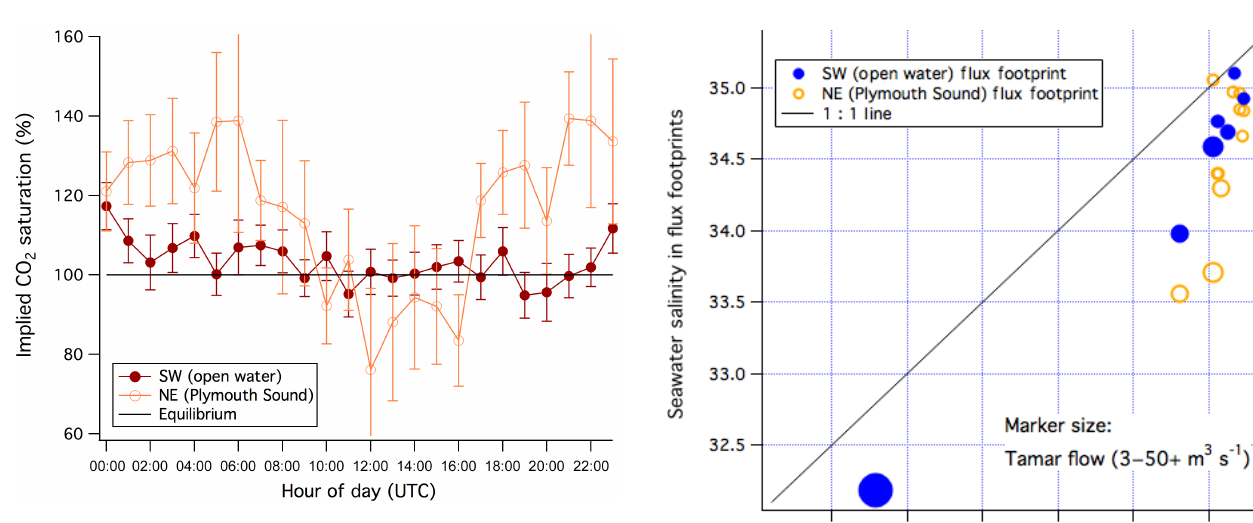
Figure 8. Mean diurnal variability in the implied seawater satura- tion of CO 2 for the for the southwest (open water) and northeast (Plymouth Sound) wind sectors. Error bars indicate standard errors.